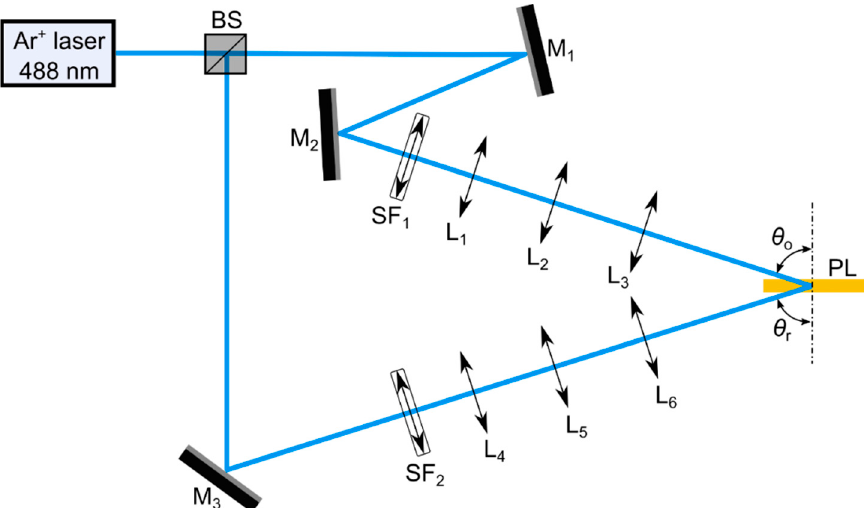
Figure 1. Holographic setup for reflection gratings. BS: beam splitter; SF i : spatial filters (microscope objective and pinhole); M i : mirrors; L i : lenses; θ o , θ r : object and reference recording angle; PL: photopolymer layer.